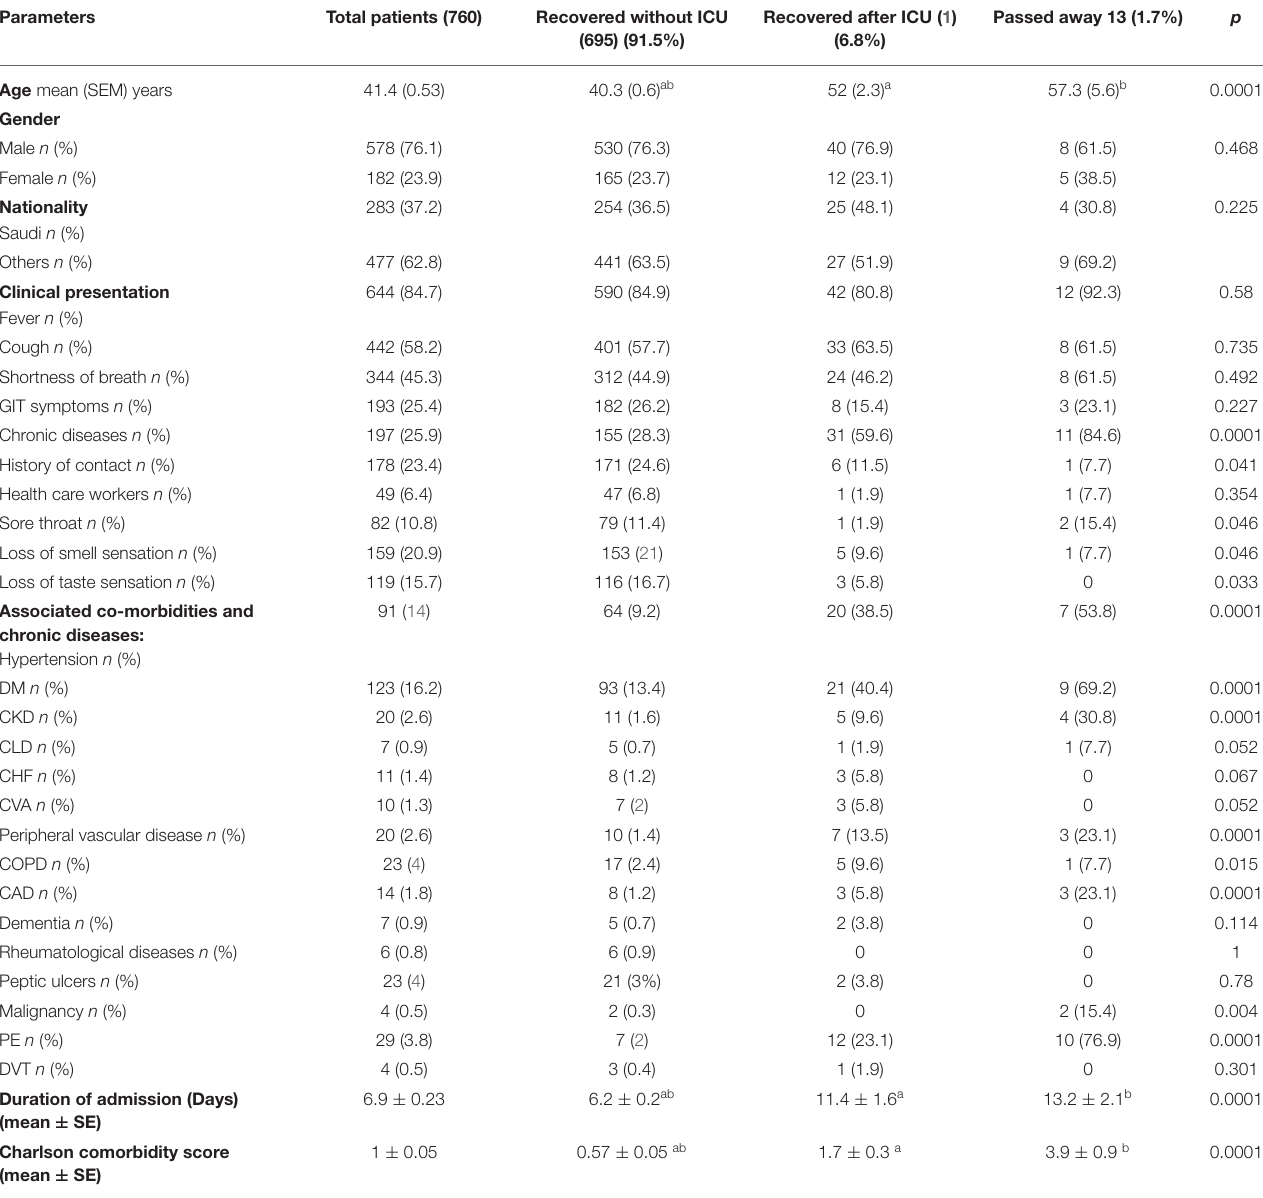
TABLE 1 | Clinical and demographic criteria of the studied groups of patients.